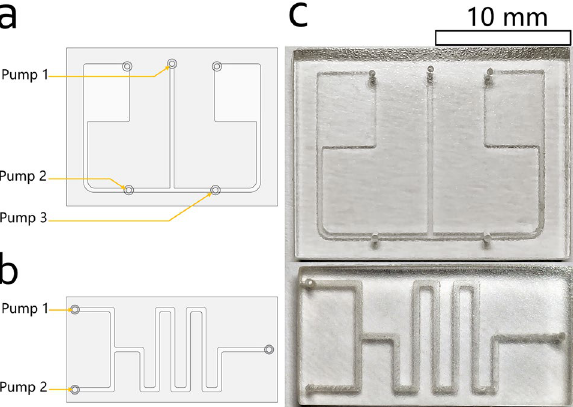
Figure 3. Single-layer 3D-printed microfluidic chips for demonstration of flow control using the system. ( a ) Design layout of the microfluidic chip (chip #1) for active flow control demonstration. This chip has one fluid inlet (top-center) connected to two on-chip reservoirs. On each reservoir is a fluid outlet (in the corner). Each connection channel has a pressure inlet for active control purposes (bottom left and right). The designed dimension of the chip is 15 × 20 × 4 mm (W × L × H) with a channel dimension of 400 × 800 µm (W × H). ( b ) Design layout of the microfluidic chip (chip #2) for passive mixing demonstration. This chip has two fluid inlets (left) connected to a serpentine formed channel, which has a fluid outlet at the end (right). The designed dimension of this chip is 10 × 20 × 4 mm (W × L × H) with a channel dimension of 400 × 800 µm (W × H). Connection setup for the experiments: ( a ) experiments #1 and #2—chip #1 is supplied with a colored sample by pump 1, while pump 2 and pump 3 control the fluid flow by adding pressure according to the program sequence; ( b ) experiment #3—chip #2 is supplied with a red-colored sample by pump 1 and green-colored sample by pump 2. The samples are mixed passively while flowing through the serpentine form channel. ( c ) Optical images of 3D-printed microfluidic chips (chip #1 and chip #2) using consumer-grade DLP